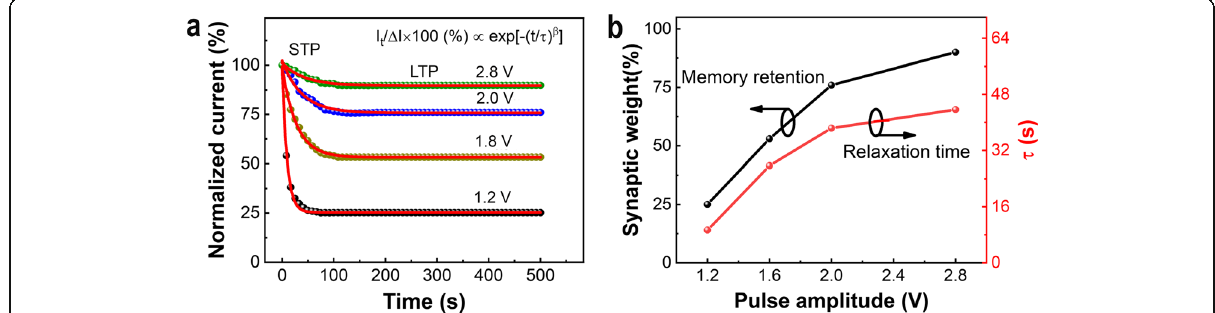
Fig. 7 Experimental results of current decay in Ag/SiO x :Ag/TiO x /p ++ -Si memristor device after the stimulation process. a The normalized current decay versus time showing the transformation from STP to LTP; b The memory retention and relaxation time ( τ ) as a function of the pulse